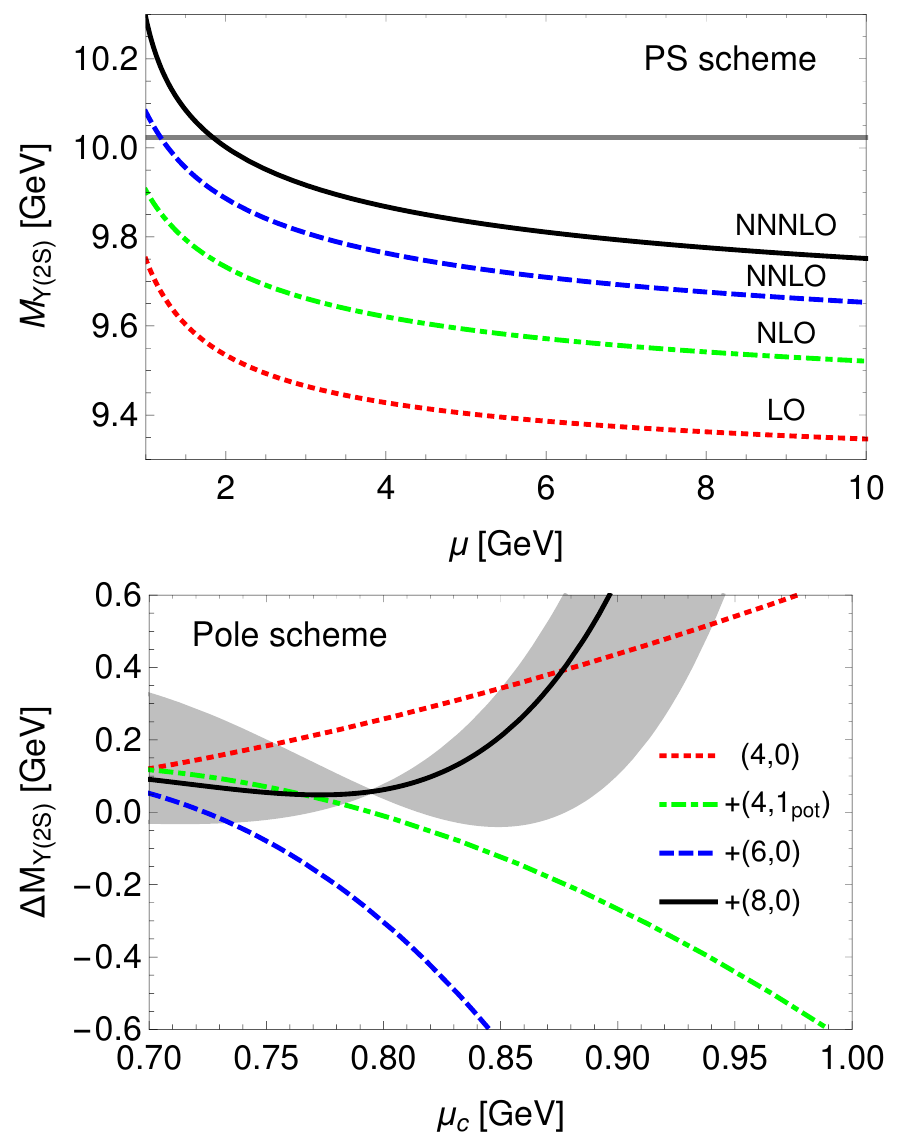
Figure 6 . The top panel shows the perturbative contribution to the mass of the (cid:7)(2 S ) resonance. The curves in the bottom panel show the e(cid:11)ects of cumulatively adding the condensate contributions ( i; j ) where i denotes the dimension and j the order in perturbation theory. The gray band is spanned by variation of O 0 by factors of 0 and 3, while O 1 and O 2 are unchanged.